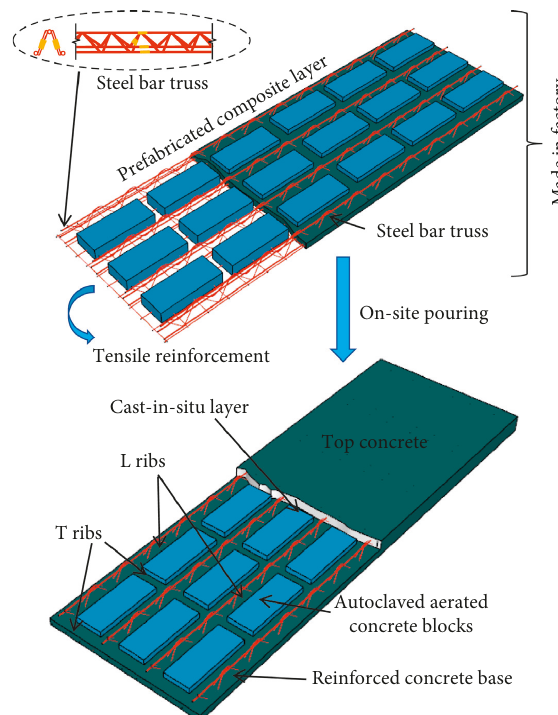
Figure 2: Fabricated lightweight multi-ribbed composite